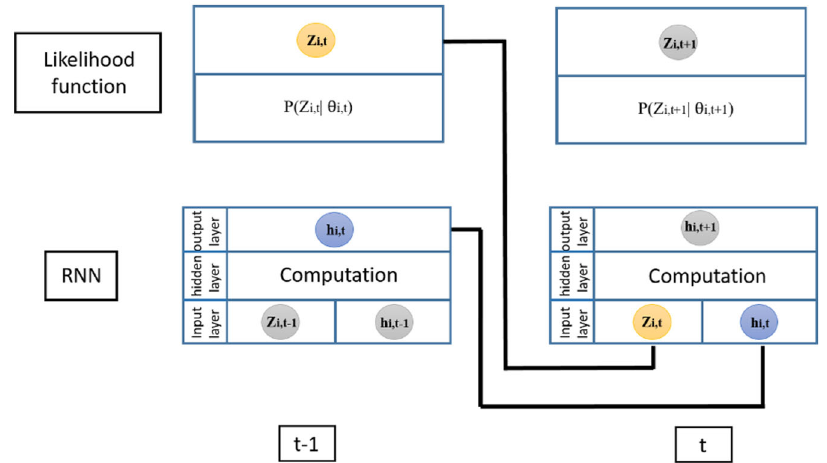
Fig. 5 Schematic diagram of DeepAR architecture.